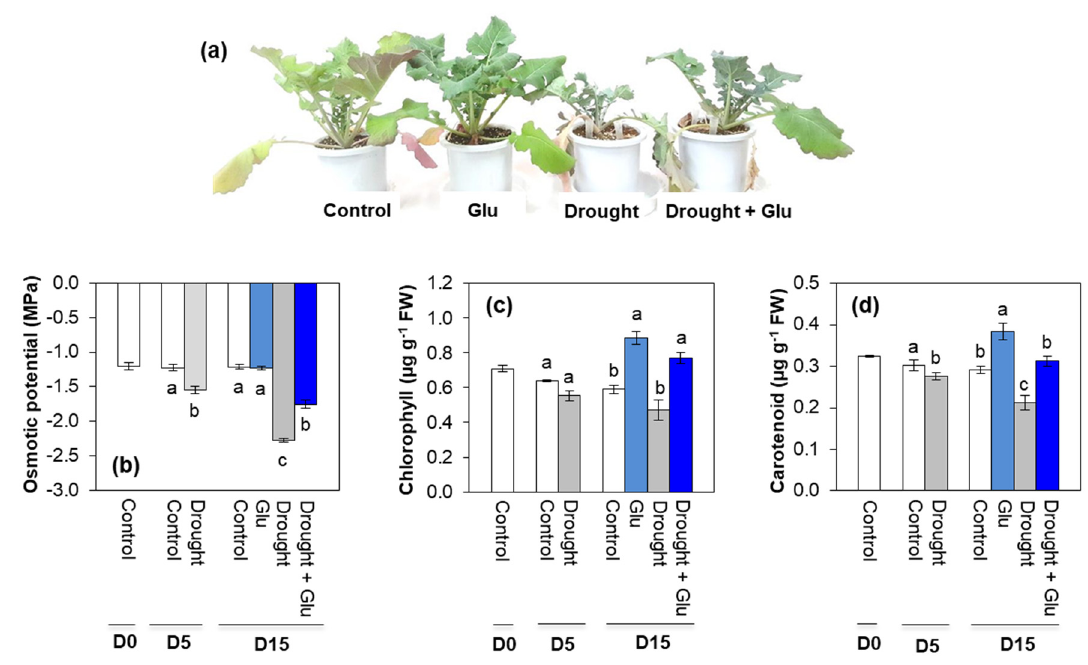
Figure 1. Effects of glutamate (Glu) application on ( a ) plant morphology, ( b ) osmotic potential, ( c ) chlorophyll, and ( d ) carotenoid content in the leaves of Brassica napus under well-watered or drought-stressed conditions. Values are represented as mean ± SE ( n = 3). Different letters on columns indicate significant difference at p < 0.05 according to Duncan’s multiple range test.